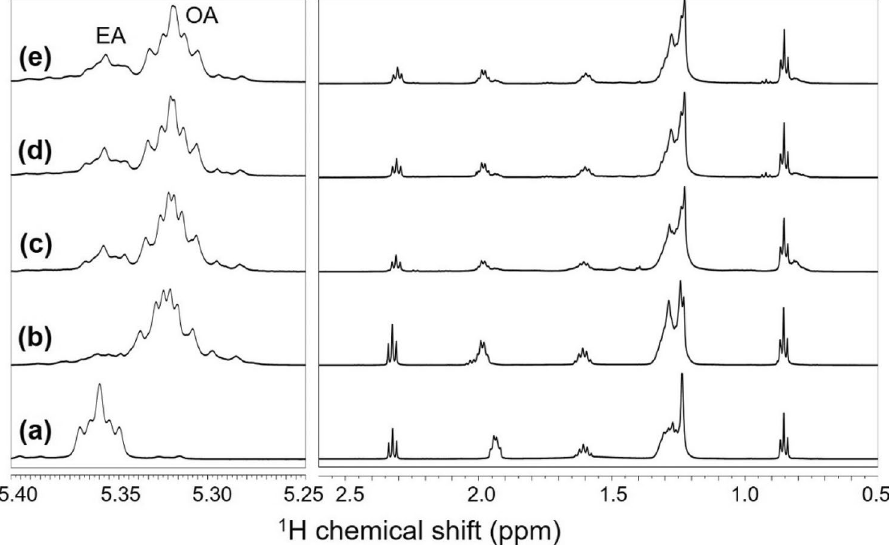
Figure 6. 1 H NMR spectra of the CDCl 3 fractions separated from the H 2 O 2 -treated samples of ( a ) elaidic acid (EA), ( b ) oleic acid (OA), ( c ) CdS-OA QD, ( d ) InP/ZnS-OA QD batch #1, and ( e ) InP/ZnS-OA QD batch